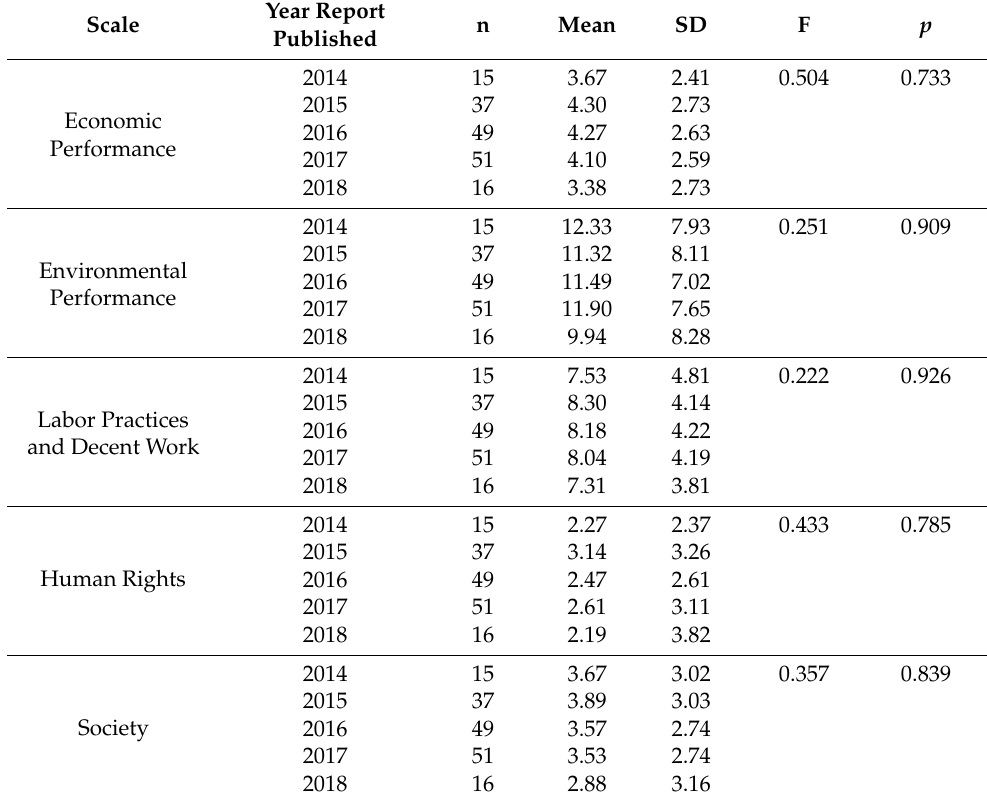
Table 9. ANOVA test results for the comparison of the economic, environmental, and social perfor- mance indicator disclosures subject to the report publication